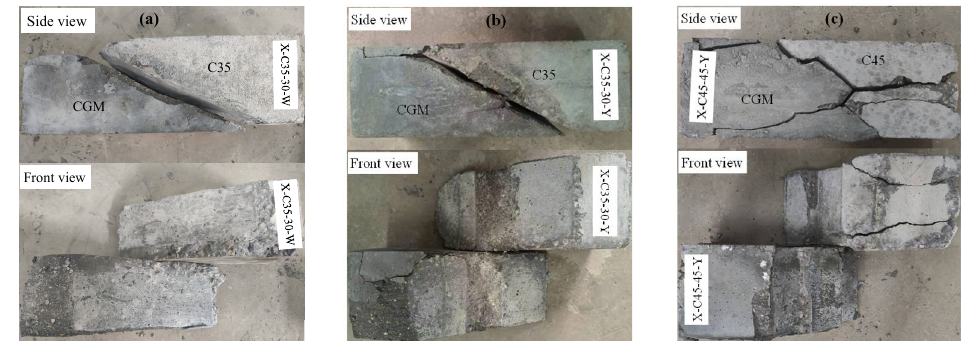
Figure 6. Typical failure modes of slant shear specimens: ( a ) pure interfacial failure; ( b ) interfacial failure with shear key cut off; ( c ) interfacial failure with substrate and partial CGM failure.